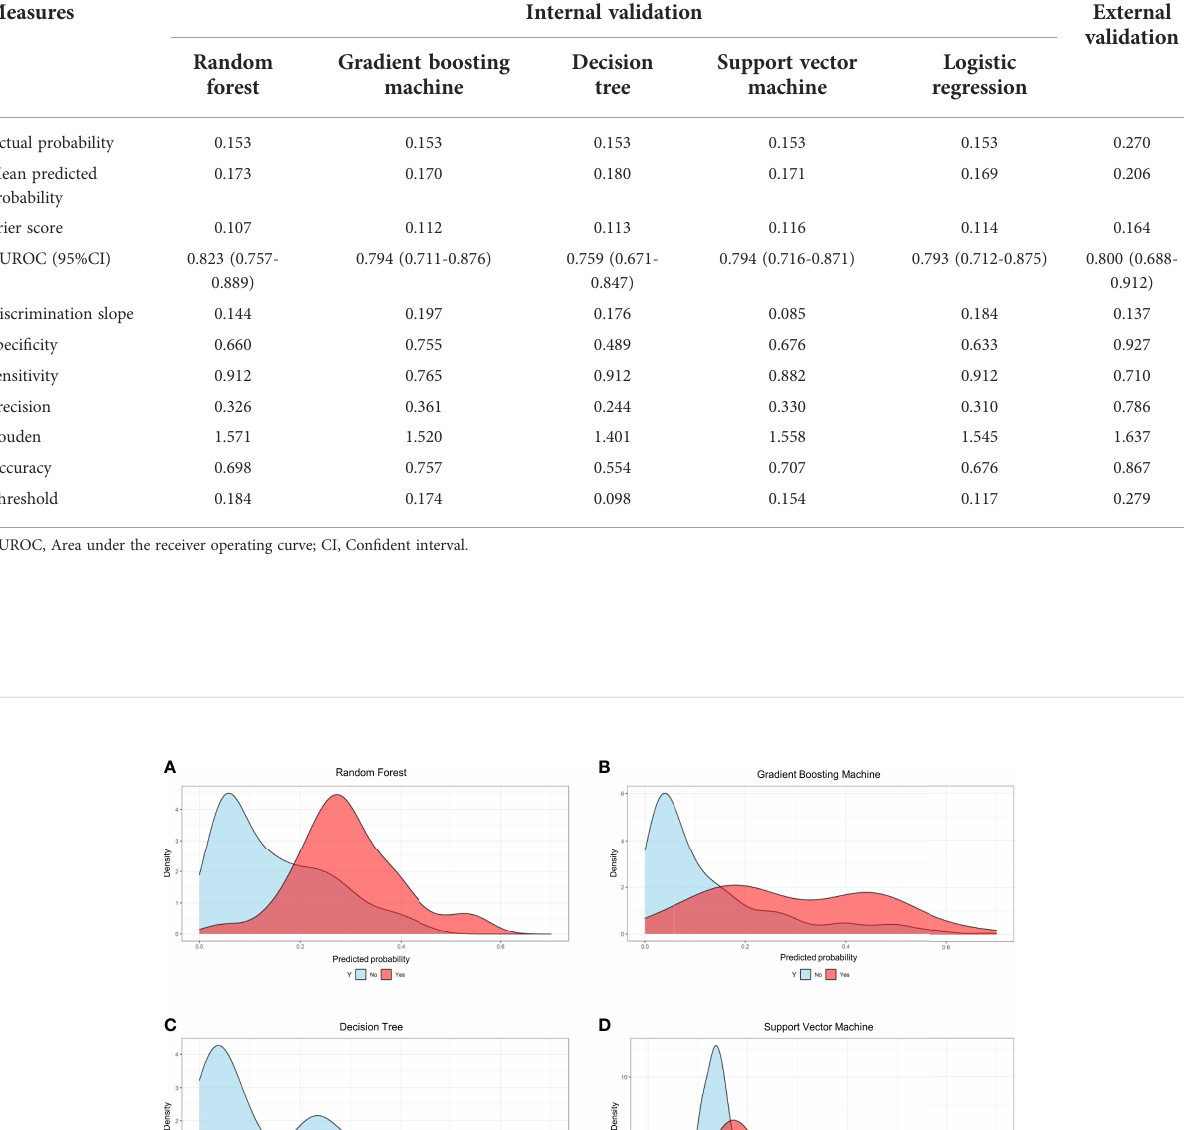
TABLE 3 Prediction performance of machine learning algorithms for predicting persistent critical illness among patients with orthopedic fracture.